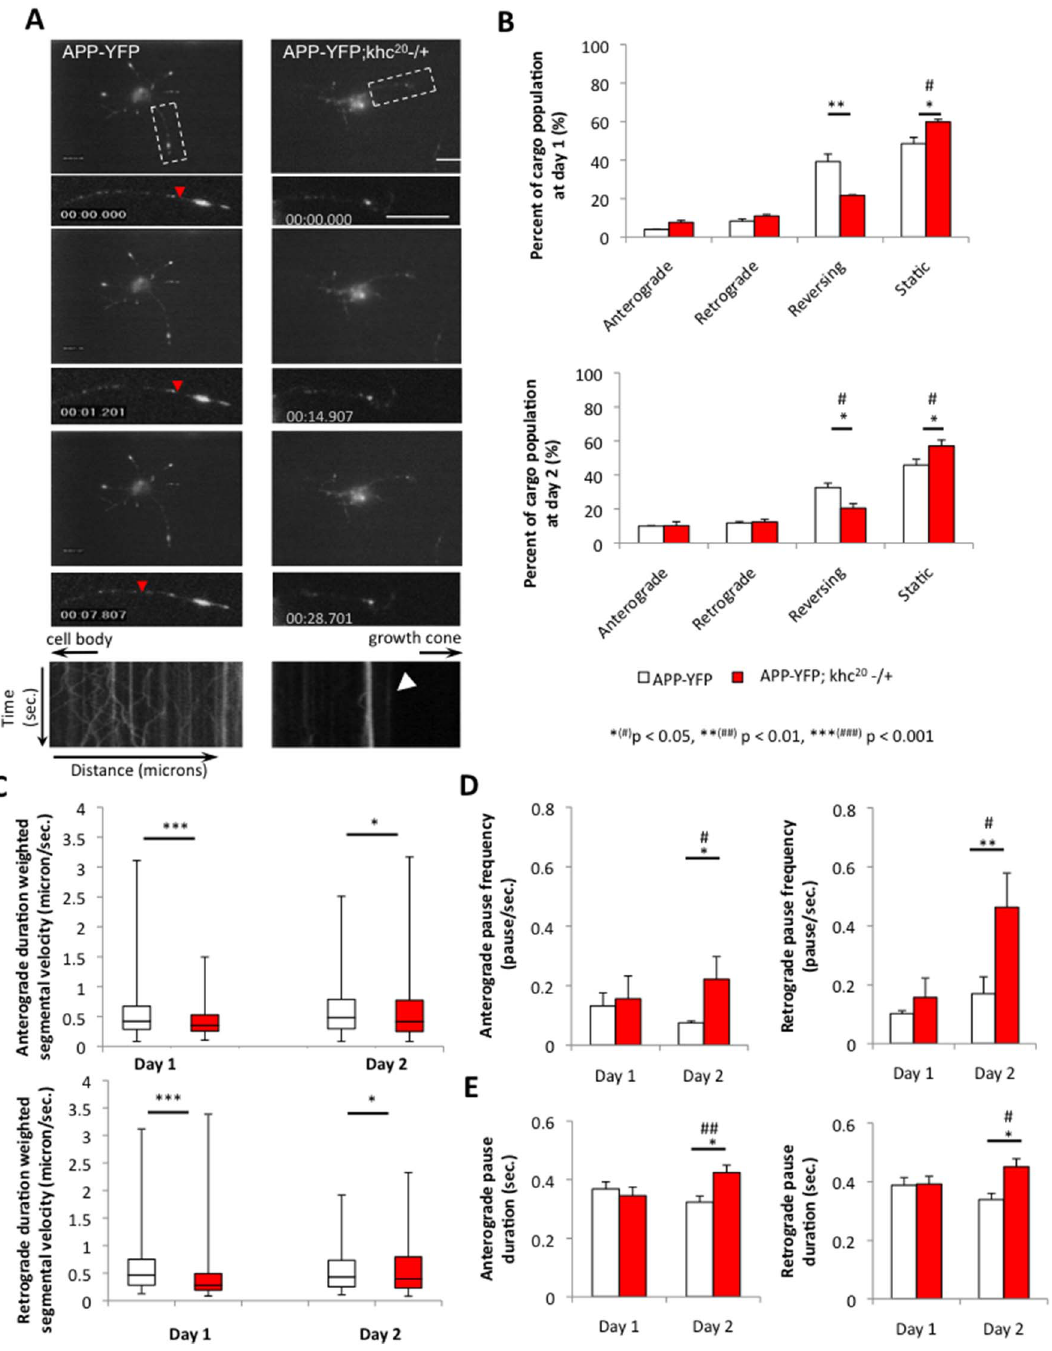
Figure 4. 50% reduction of kinesin-1 perturbs the movement of APP vesicles. ( A ) A representative movie montage from a single neuron is shown from a primary neuronal culture expressing APP-YFP in the context of 100% kinesin-1 (APP-YFP) or 50% kinesin-1 (APP-YFP;khc 20 2 / + ). The axonal neurite is boxed and is enlarged with its kymograph. Note that 50% reduction of kinesin-1 (APP-YFP;khc 20 2 / + ) causes many stalled APP-YFP vesicles compared to neurites containing 100% kinesin-1 (arrowhead). Robust movement is seen in the kymograph with 100% kinesin-1 (APP-YFP, red arrowhead) in contrast to stalled vesicles seen in the kymograph with 50% reduction of kinesin-1. Y-axis depicts time in seconds and X-axis depicts distance traveled in microns. The cell body and growth cone directions are depicted by the arrows. Bar=10 microns. ( B ) Quantitative analysis of the percent of cargo population indicates that 50% reduction of kinesin-1 significantly increases the percentage of stationary vesicles (p day1 =0.002 and p day2 =0.031) and decreases the percentage of reversing vesicles compared to 100% kinesin-1 at both day 1 and day 2 (p day1 =0.013p day2 =0.021) both at day 1 and day 2. ( C ) Both the anterograde (p day1 =0.0002 and p day2 =0.045) and retrograde (p day1 =5.523E-5 and p day2 =0.044) median duration weighted segmental APP velocities significantly decreased with 50% reduction of kinesin-1 compared to 100% kinesin-1 at day 1 and day 2. Upper and lower box edges represent 75 th percentile and 25 th percentile, respectively. Upper and lower whiskers represent the maximum and minimum of the data, respectively. The horizontal line represents the median. Significance was determined by Wilcoxon-Mann-Whitney rank sum test for nonparametric distributions. At day 2, both the anterograde and retrograde ( D ) pause frequencies (p antero =0.034 and p retro =0.002) and ( E ) pause